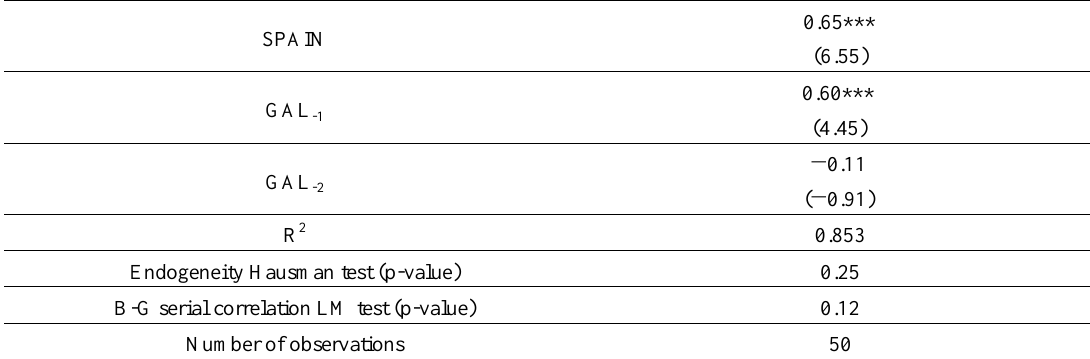
Table 3 : Econometric estimate of equation (1)